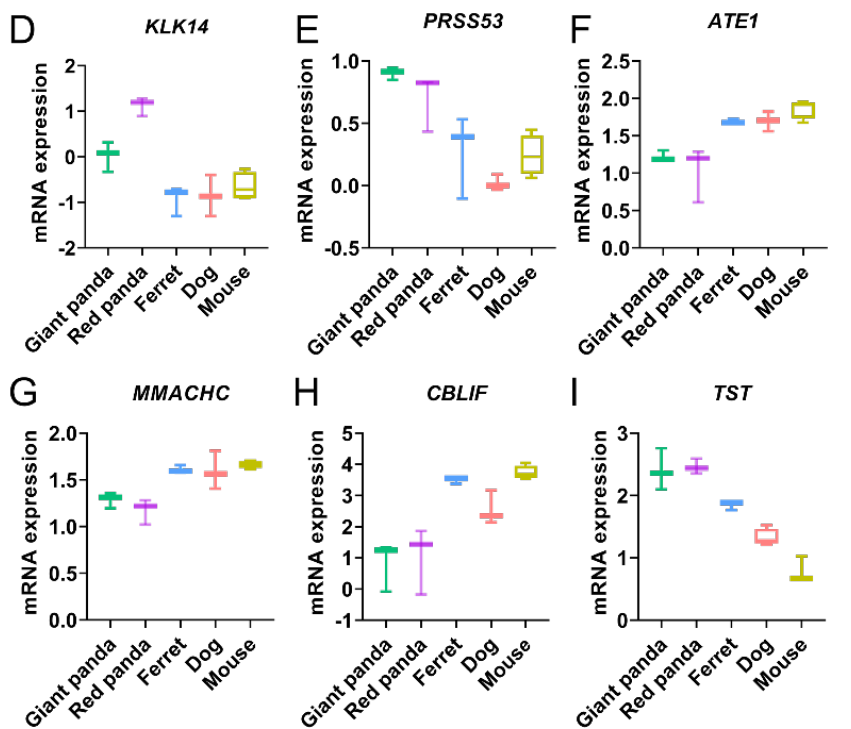
Figure 4. The expression trends of the convergent DEGs associated with carbohydrate utilization ( A ), bile secretion ( B , C ), Arg and Lys metabolism ( D – F ), vitamin B12 utilization ( G , H ) and cyanide detoxification ( I ) in stomach and small intestine samples. Y-axis represents normalized and log- transformed expression levels. Boxplot edges indicate the 25th and 75th percentiles. Different species are represented by different colors.